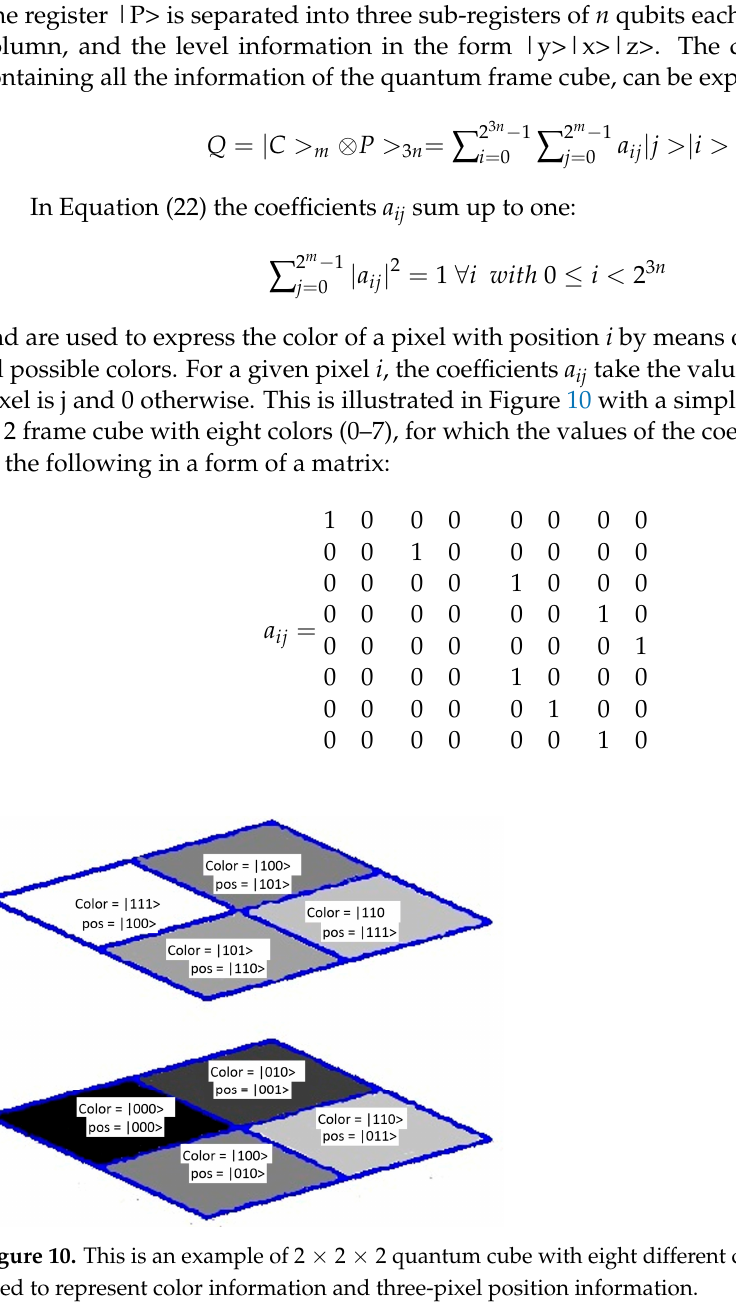
Figure 11. Implementation of the quantum circuit for 3D fi ltering. As shown in the block diagram of Figure 11, at the output of the quantum fi ltering circuit we actually fi nd the input image cube. Additionally, by exploiting the quantum interference phenomenon, we can use an additional qubit initially in state |0 (cid:3408) to rein- terpret the quantum image cube as a superposition of two image cubes. For example, for